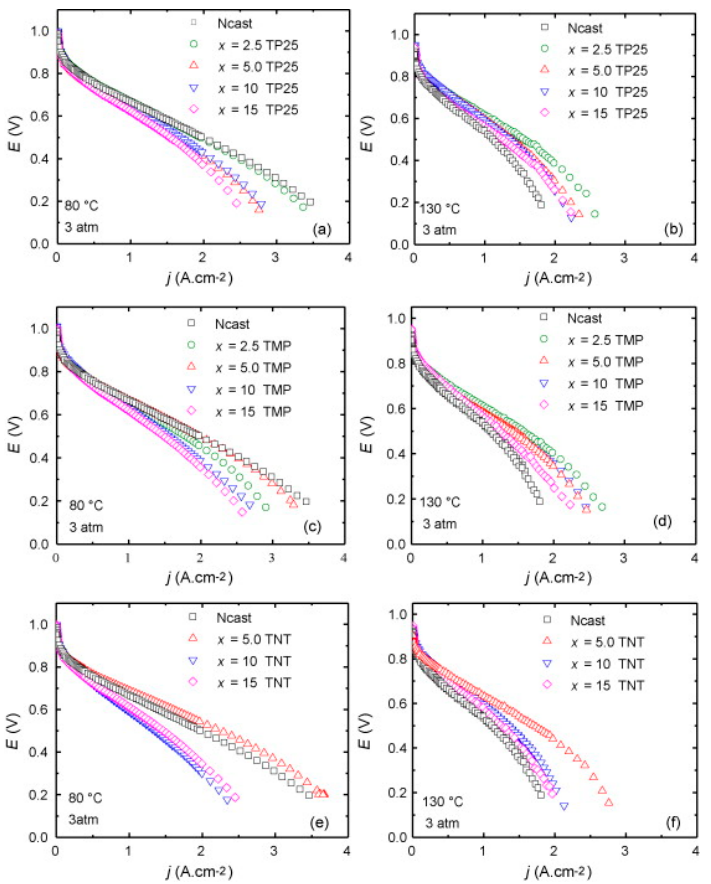
Figure 4. Polarization ( I–V) curves for the ( a , b ) TP25, ( c , d ) TMP, and ( e , f ) titanium oxide nanotube (TNT) composites measured at 80 and 130 °C; reproduced with permission from [154].